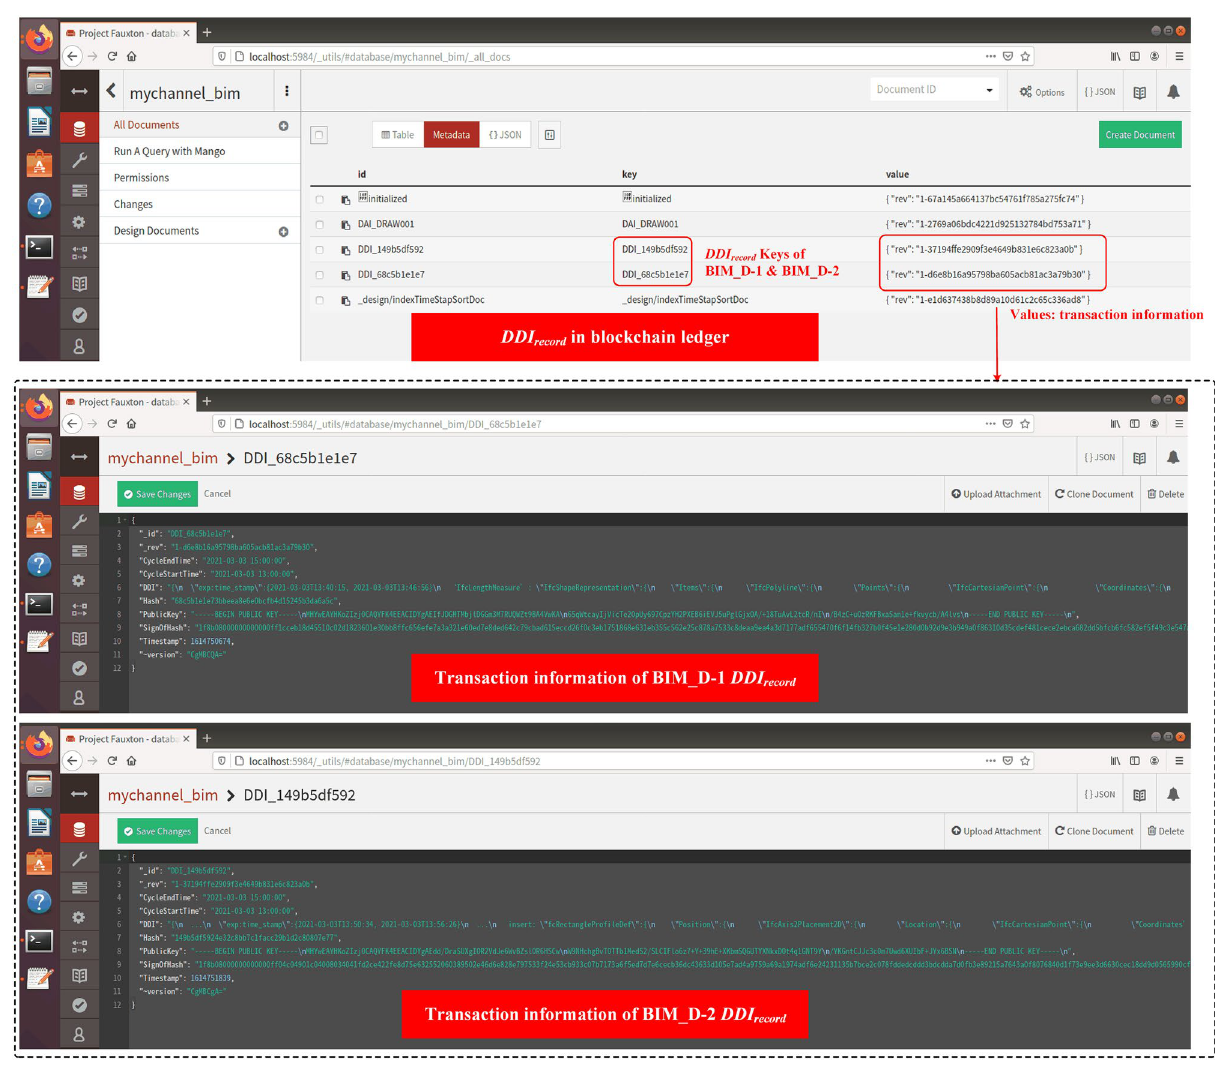
Figure 19. BIM drawing design information in blockchain